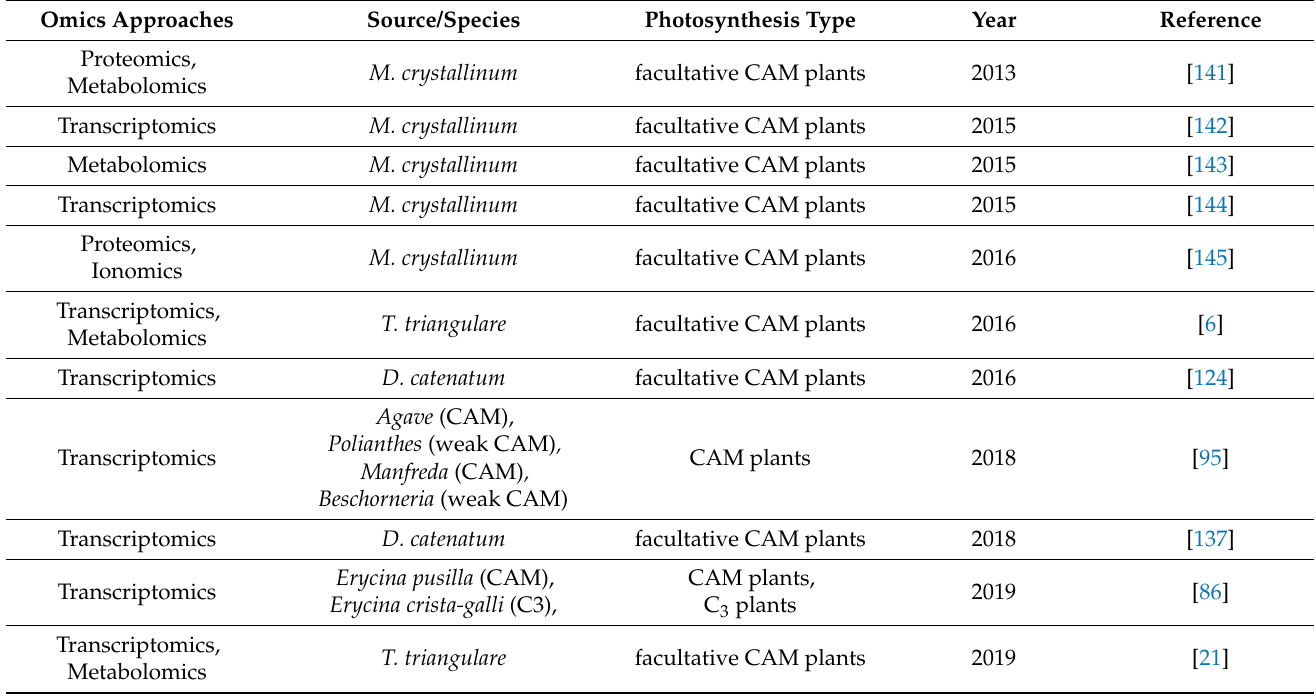
Table 2. Omics approaches involved to reveal the molecular changes during the C 3 –CAM transition in facultative CAM